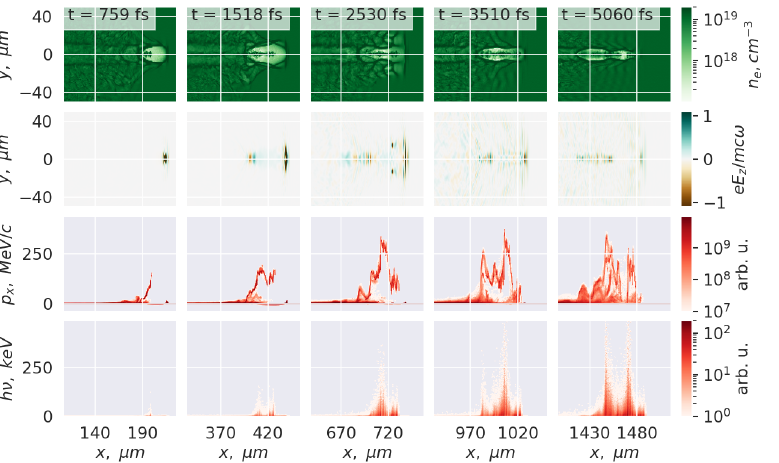
Figure 1. Simulation results for a Gaussian laser pulse with a duration of 11 fs. First row—electron density distribution, second row—out-of-plane electric field distribution (it corresponds to the laser pulse field), third row—electron phase space, fourth row—photon phase space. Columns refer to different instants of time shown at top left corners of the first row